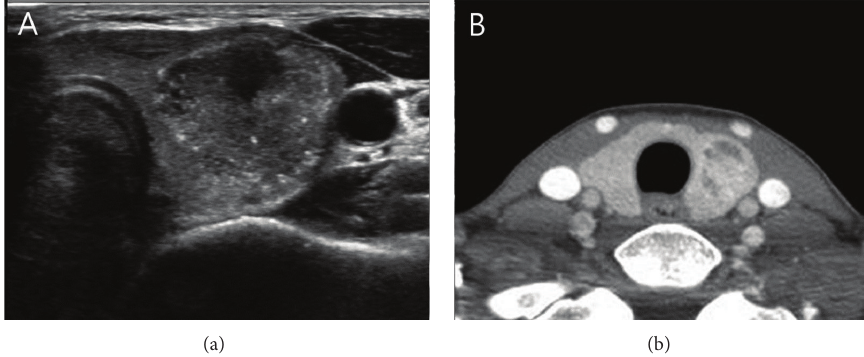
Figure 3: 44-year-old woman with papillary thyroid carcinoma without extrathyroidal extension. On contrast to the US finding which shows the tumor closely attached to the capsule, CT findings revealed the complete parenchymal envelop around the tumor.